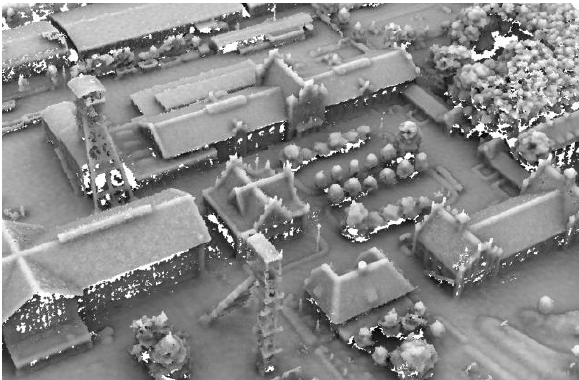
Figure 7. Exemplary point cloud generated with software SURE For evaluation of the DIM point clouds provided by the participants, the approach already described in Cavegn et al.